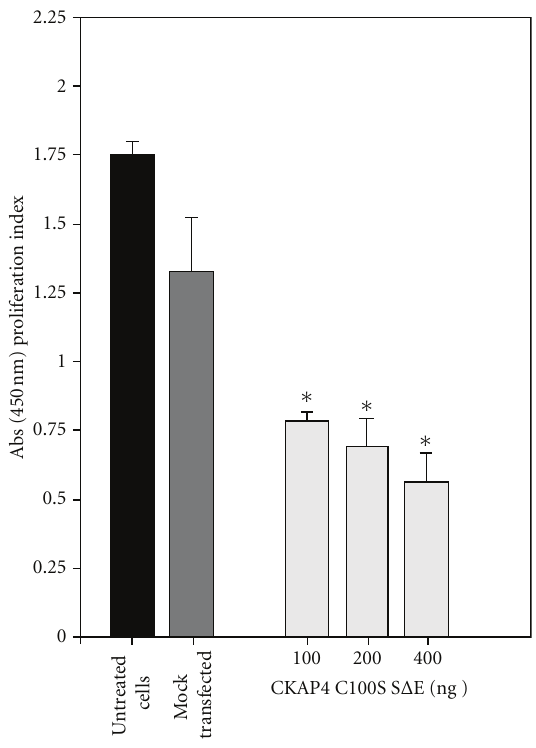
Figure 6: CKAP4C100S/S Δ E expression inhibits HeLa cell prolif- eration . HeLa cells were mock transfected (Fugene; control) or transfected with 100, 200, or 400 ng of CKAP4C100S/S Δ E DNA. After an additional 24 hours of growth, proliferation was measured using the WST-1 proliferation assay (Biovision) according to the manufacturer’s protocol. Each data point is the mean and SD from 12 independent wells. Statistically significant di ff erences in the rate of cellular proliferation were detected for HeLa cells transfected with 100, 200, and 400 ng of CKAP4C100S/S Δ E DNA versus mock- transfected cells using the students t -test ( ∗ P < 0 .